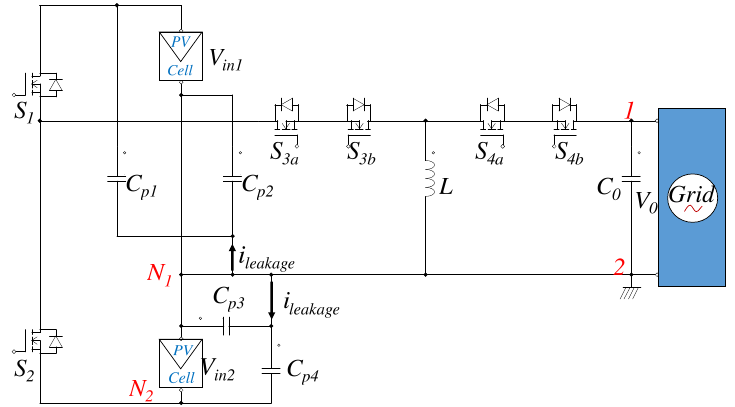
Figure 11. Proposed inverters with PV panels and parasitic capacitors in